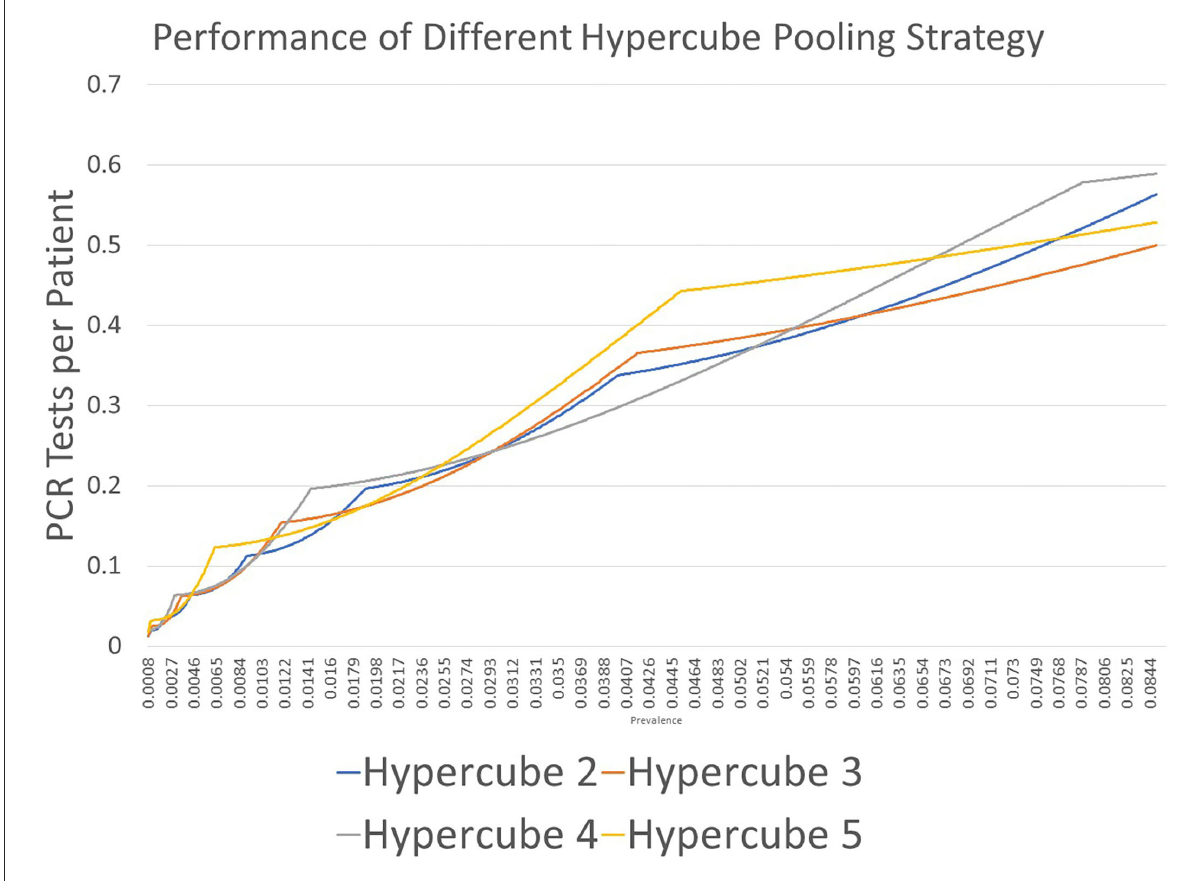
FIGURE1 Results of PCR tests for each patient using the hypercube pooling strategy with edge values of 2 (Hypercube 2), 3 (Hypercube 3), 4 (Hypercube 4), and 5 (Hypercube 5). The quantization effects are displayed. Every strategy has an area in which its performance is